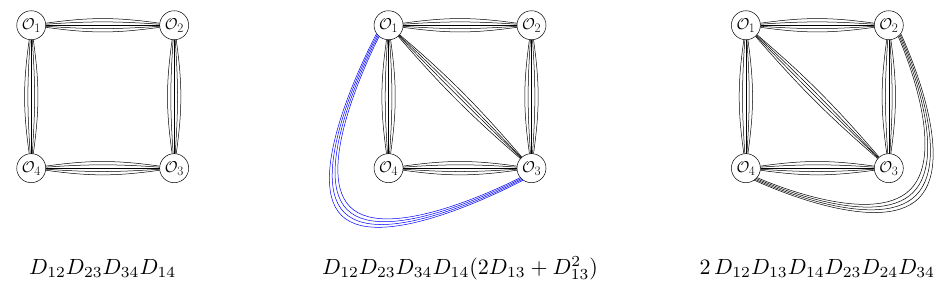
Figure 3 . Non-extremal four-point topologies, where each operator couples to at least two distinct other operators. Bundles denote products of one or more Wick